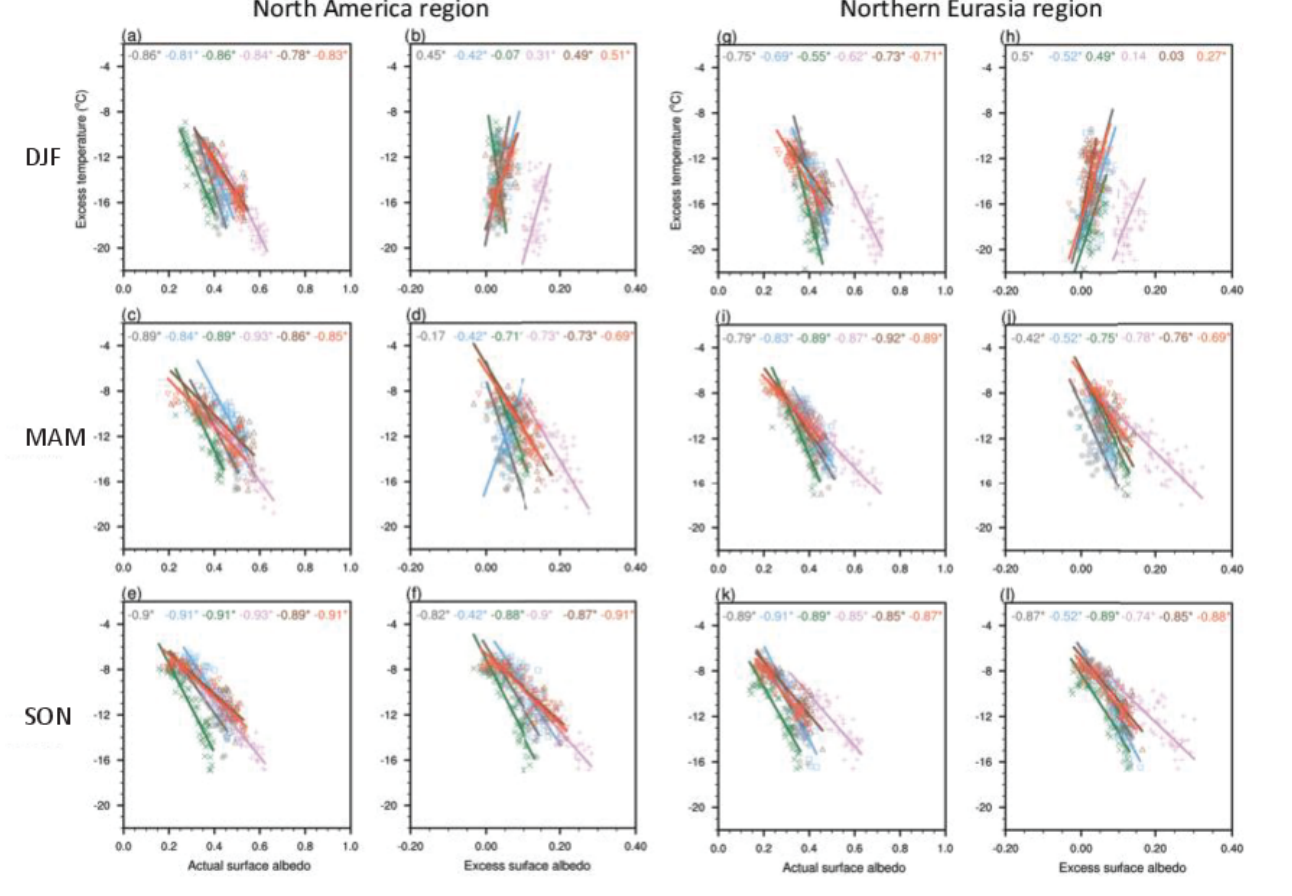
Figure 5. As Fig. 4, but for surface albedo.